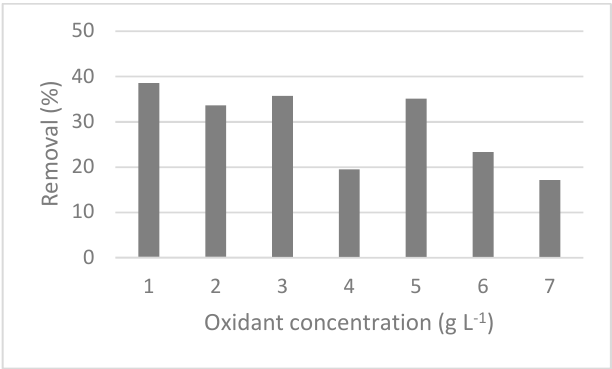
Figure 1. Effect of hydrogen peroxide oxidation on the removal of total